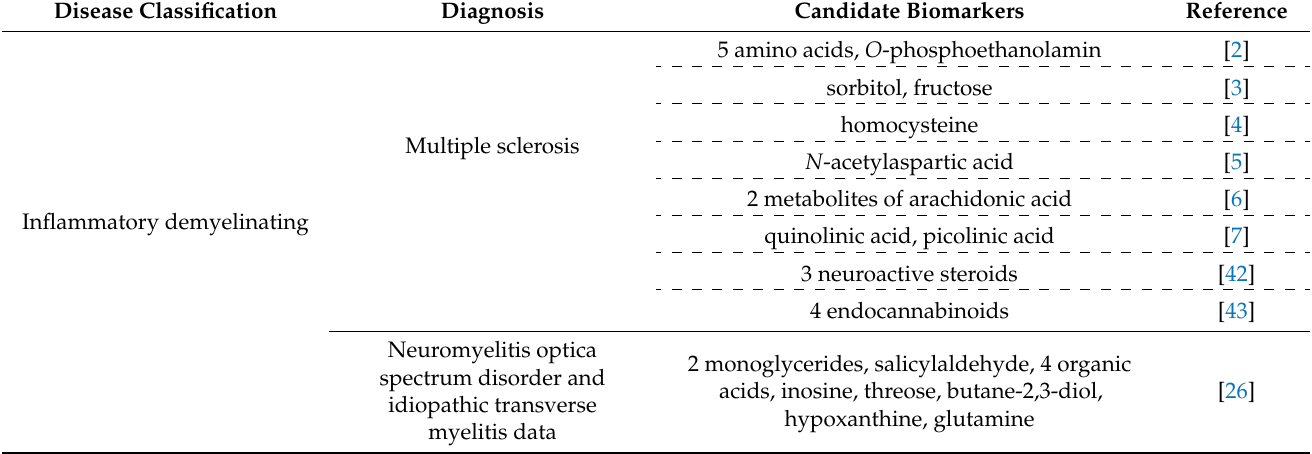
Table 2. Candidate low-molecular-weight biomarkers, discovered using GC–MS methods, for different types of diseases. Disease